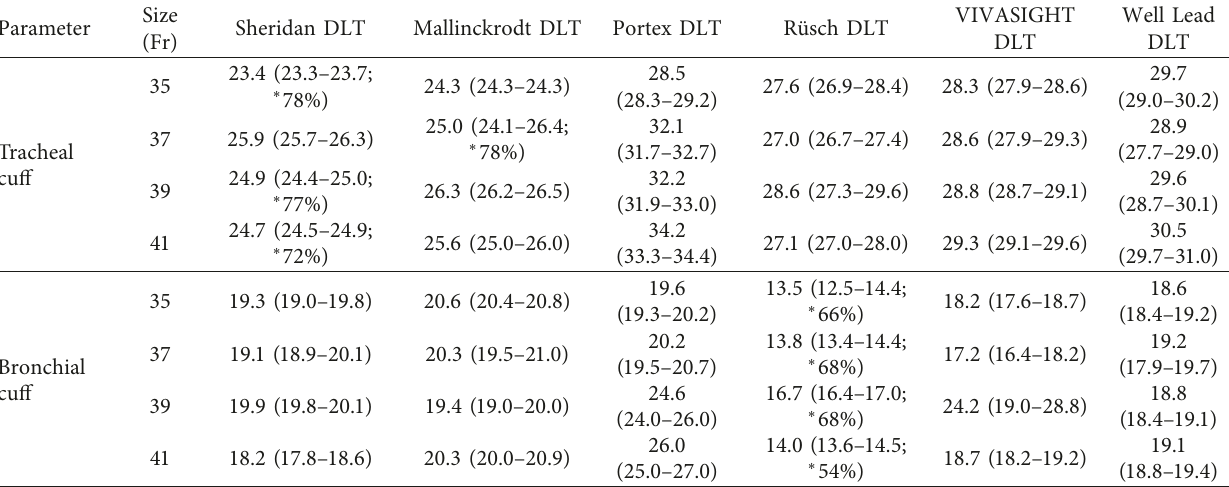
Table 5: Tracheal and bronchial outer cuff diameters of the investigated left-sided double-lumen endobronchial tubes (DLTs) measured at a cuff pressure of 20cm H 2 O.